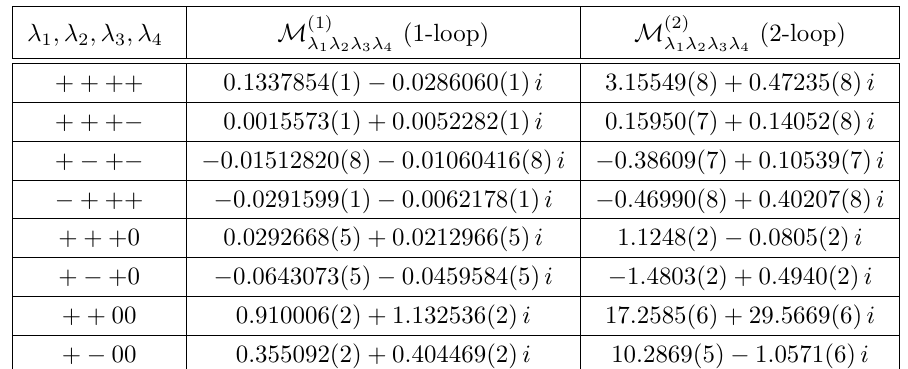
Table 3. Top-quark contributions to the helicity amplitudes for gg → ZZ in (6.2). The results are given for the physical phase space point s/m 2 m t = 1 and include only the new contributions of class A defined in section 2.2. The numbers in parentheses denote the uncertainty in the last digit.